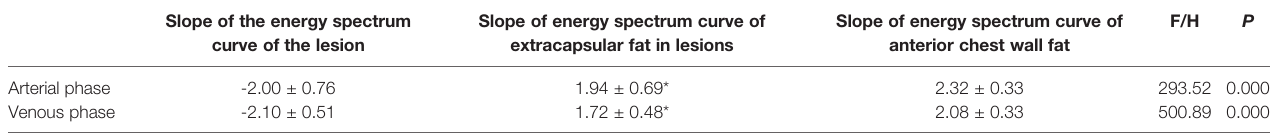
TABLE 2 | Slopes of energy spectrum curves, extracapsular fat and anterior chest wall fat of TETs stage I. Slope of the energy spectrum curve of the